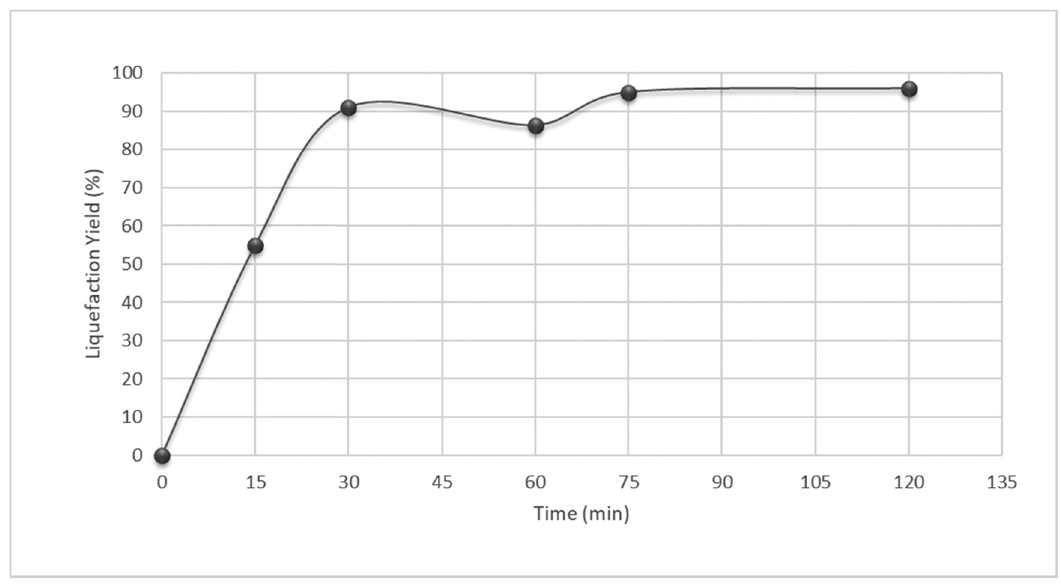
Figure 3: Liquefaction yield ( % ) with time ( minutes ) for